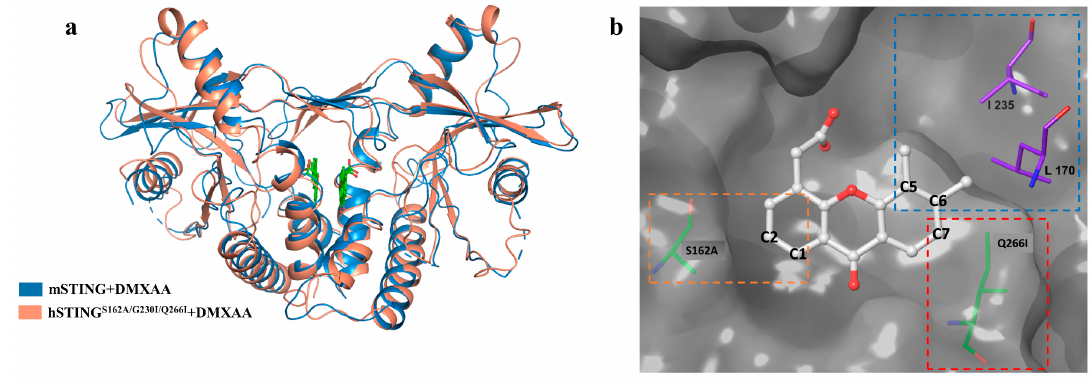
Figure 6. Research basis and our optimized hotspots for DMXAA and CMA derivatives. ( a ) Super- position of the structure of DMXAA bound to mSTING (PDB: 4LOL, shown as dark blue) with the structure of DMXAA bound to hSTING S162A/G230I/Q266I (PDB: 4QXR, shown as orange). ( b ) Details of DMXAA bound to mutated hSTING (PDB: 4QXR). The dashed line boxes represent the potential modification sites. Amino residues shown in green are mutated residues